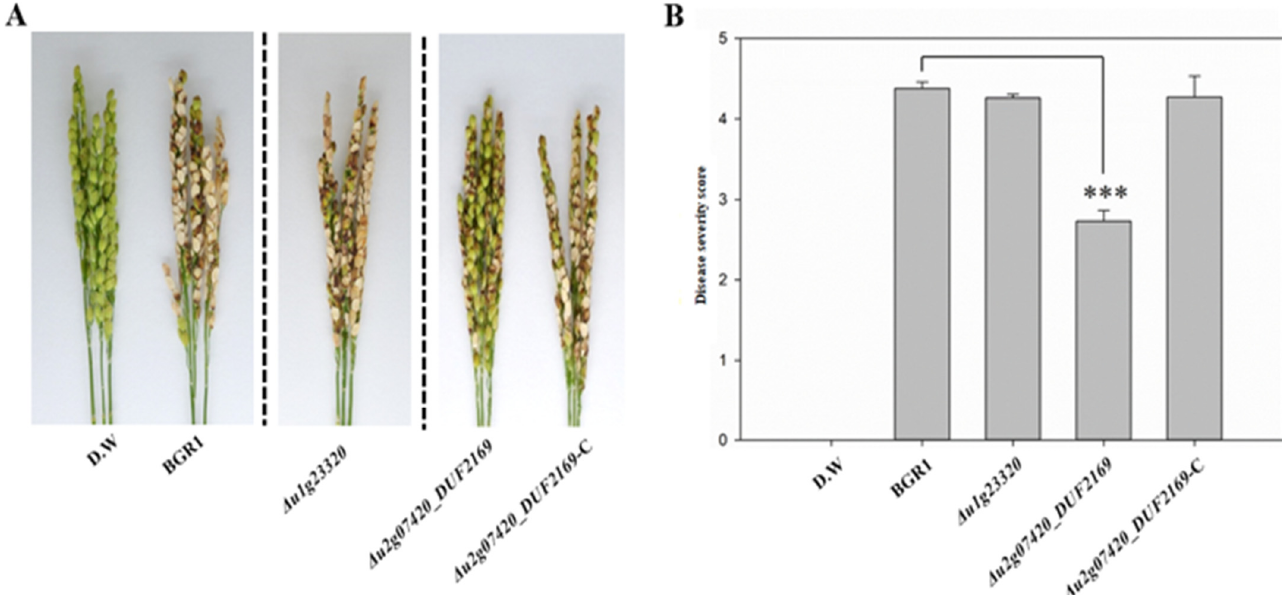
Figure 3. In vivo pathogenicity assay at the reproductive stage to assess the virulence of Δ u1g23320 and Δ u2g07420DUF2169 . Representative of three replicates ( A ). Disease severity on the rice panicles was calculated on a scale of 0 to 5 after inoculating the bacterial suspension ( B ). Data are presented as the mean ± S.D. of three replicates ( n = 3). Mean values followed by the same letters are not sig-nificantly different according to Tukey’s HSD test (*** p < 0.001). Disease symptoms at 8 days post-inoculation. Distilled water (D.W.) was used as the negative control.